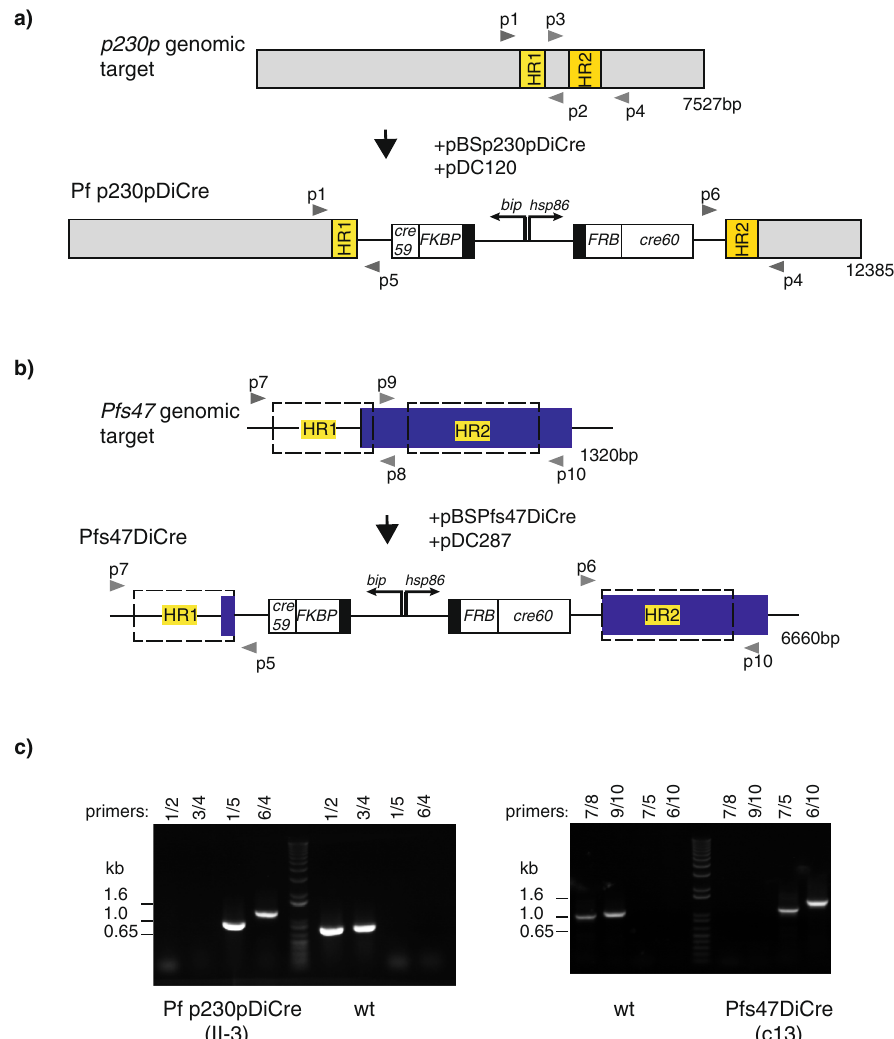
Figure 3. Successful generation of P. falciparum parasite lines expressing DiCre recombinase using CRISPR- Cas9. ( a ) Schematic of wild type p230p ORF and modified ORF containing the DiCre recombinase expression cassettes following transfection of 3D7 with pBSp230pDiCre and pDC120 (pDC2-hDHFR-yFCU plasmid carrying the guide sequence). Homology regions (HRs) used for targeting were 500 bp (HR1) and 644 bp (HR2) in size. ( b ) Schematic of wild type pfs47 locus and modified, DiCre-expressing pfs47 locus. The blue box depicts the pfs47 ORF, and hashed boxes the DNA regions used for homologous repair. Transfection of 3D7 with pBSPfs47DiCre and pDC287 (the plasmid carrying the guide sequence for Pfs47 targeting) resulted in the disruption of the pfs47 ORF. ( c ) PCR screen on wild type and transgenic parasite clones (II-3 and Pfs47-13) showing successful integration of the DiCre cassette into the targeted loci. Primer pairs 1/2 and 3/4 amplify fragments of p230p in wild type parasites only with expected sizes of 772 bp and 771 bp respectively. Primer pairs 1/5 and 4/6 amplify DNA only after successful integration into p230p with expected sizes of 947 bp and 1229 bp respectively. Primer pairs 7/8 and 9/10 amplify 1042 bp and 1114 bp fragments from the pfs47 wild type locus only; whereas primer pairs 5/7 and 6/10 only amplify the expected 1257 bp and 1555 bp bands after successful integration. Primers used for amplification are shown on the top of each panel, as well as in the schematics in a) and b). DNA marker sizes are indicated on the left in